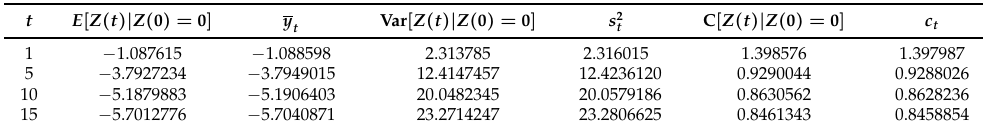
Table 3. For the same choices of the parameters of Figure 6, the conditional mean, variance, and coefficient of variation of Z ( t ) are compared with the estimated values y means of Algorithm 1.